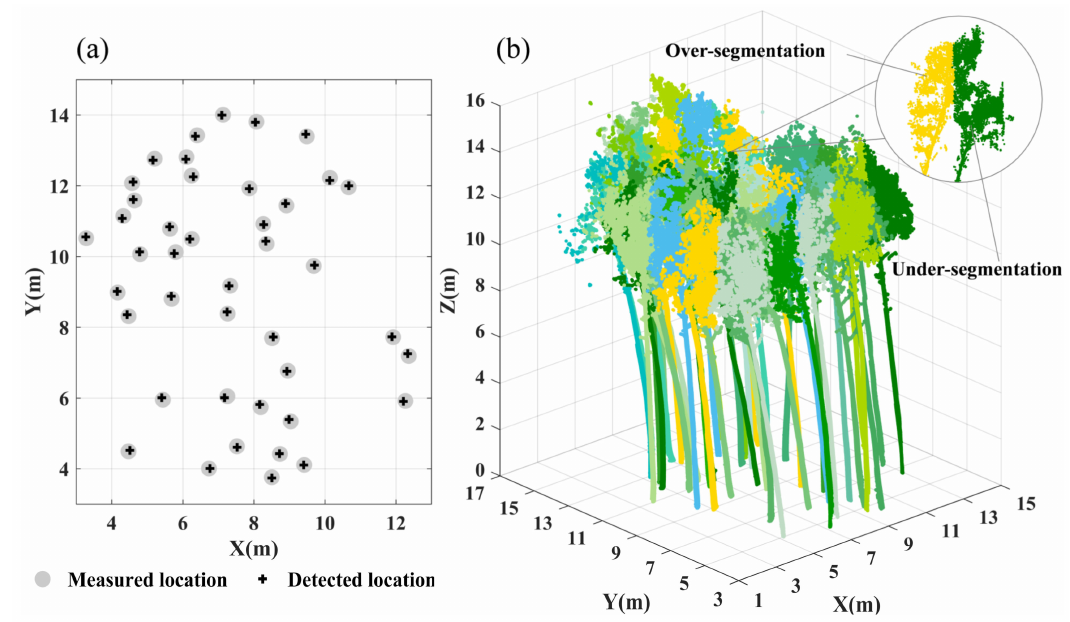
Figure 7. ( a ) Measured and detected locations of individual Moso bamboos; ( b ) segmented points of individual Moso bamboos.